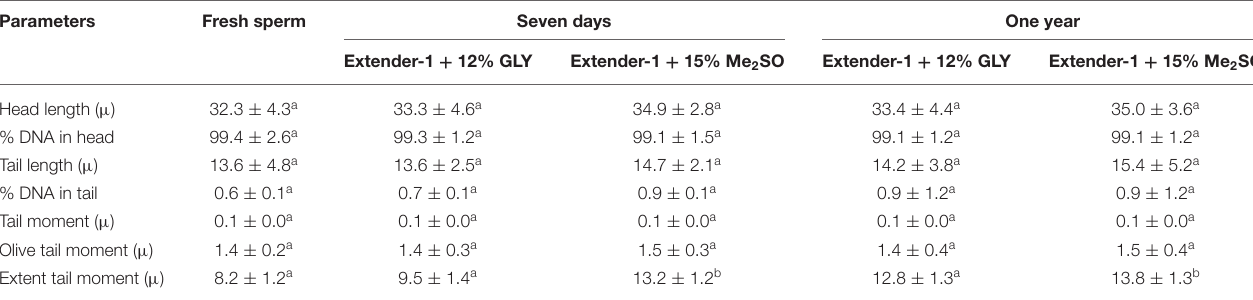
TABLE 1 | Results of comet assay parameters (mean ± standard deviation) of fresh and cryopreserved sperm (7-day and 1-year) samples. Parameters Fresh sperm Seven days One year Extender-1 + 12% GLY Extender-1 + 15% Me 2 SO Extender-1 + 12% GLY Extender-1 + 15% Me 2